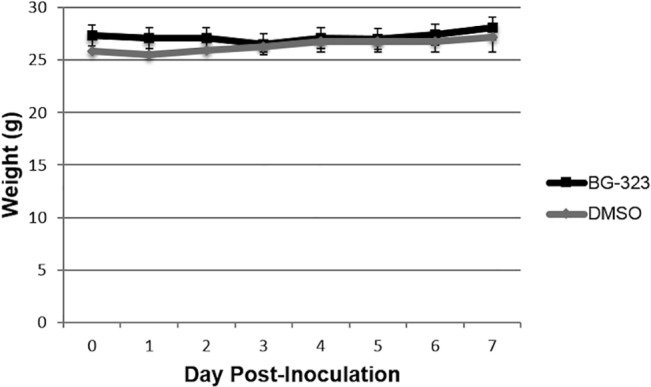
Effects of BG-323 administration on mouse weight.50 mg/kg BG-323 or DMSO were administered intraperitoneally (IP) to mice and weights were monitored for 7 days in order to determine any gross toxic effects of BG-323.